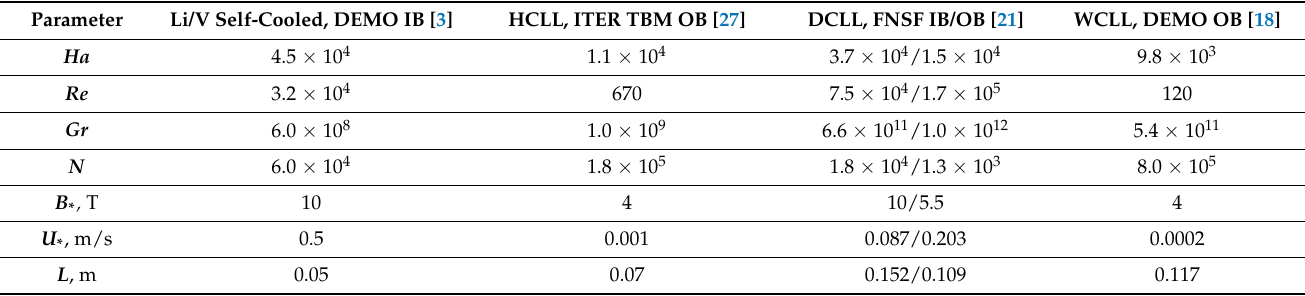
Table 1. Examples of the dimensionless parameters in several blanket concepts for DEMO, ITER TBM and FNSF, including inboard (IB) and outboard (OB) blankets. Dimensional parameters B ∗ , U ∗ , and L are also shown.